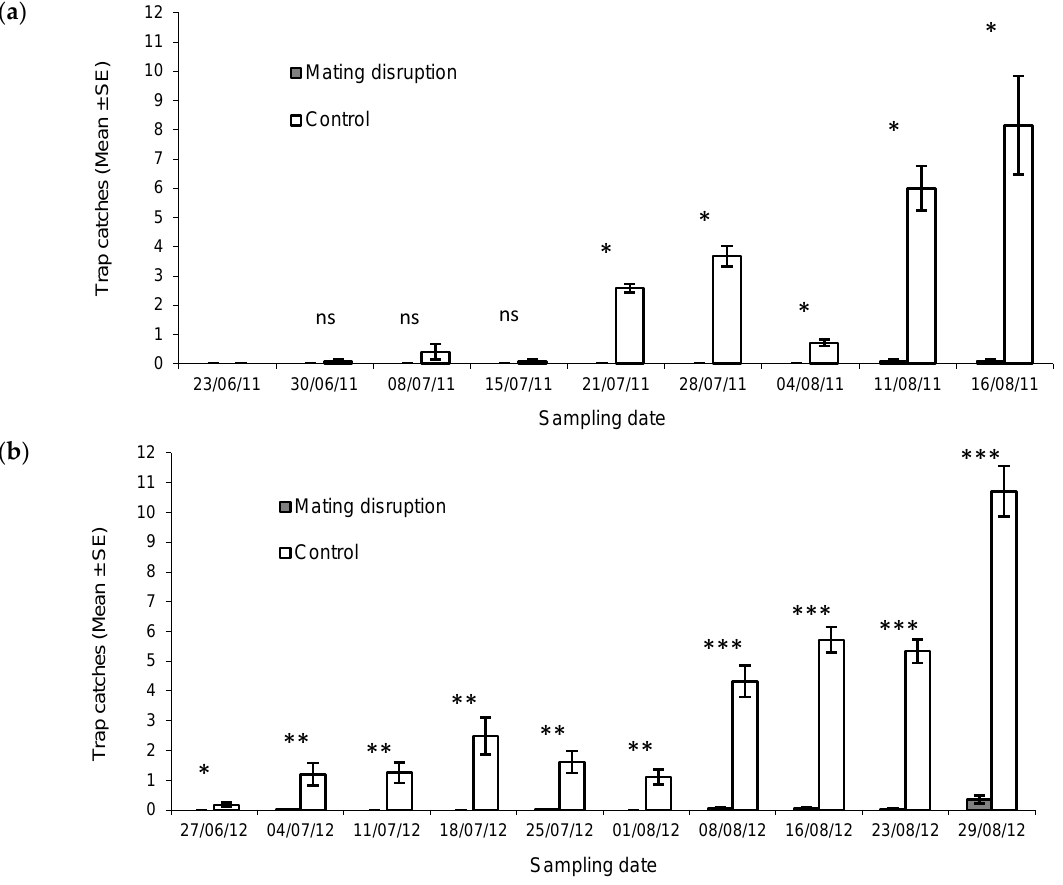
Figure 1. Mean number of Helicoverpa armigera males trapped per night in pheromone-treated (mating disruption) and pheromone-untreated (control) areas in 2011 ( a ) and 2012 ( b ). Bars represent the standard errors of the means. Male catches were compared using the Mann–Whitney U test: ns = not significant; * p < 0.05; ** p < 0.01; *** p < 0.001.